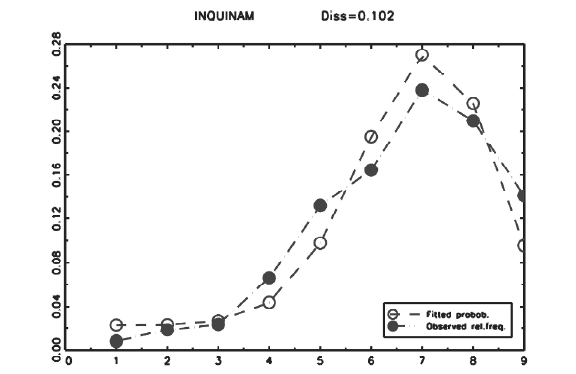
Figure 6 – Frequency and probability distributions of